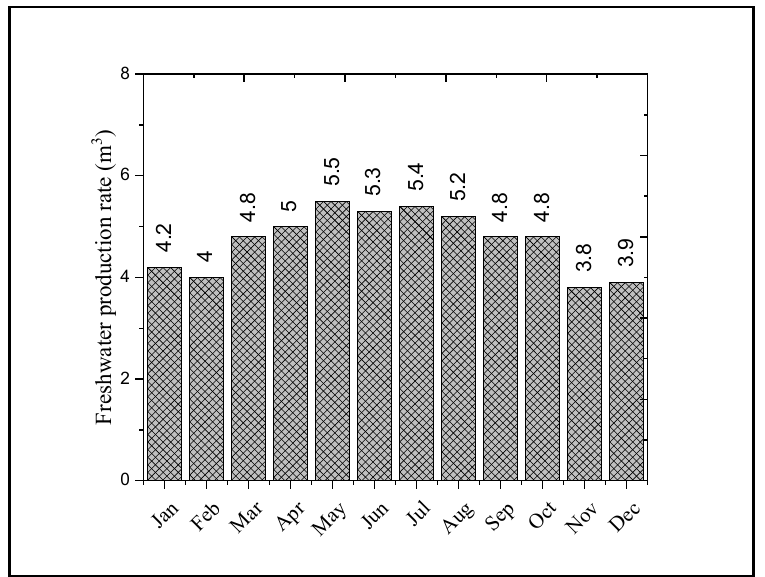
Figure 10. The amount of freshwater produced and the heat taken by the desalination plant for the months of the year.